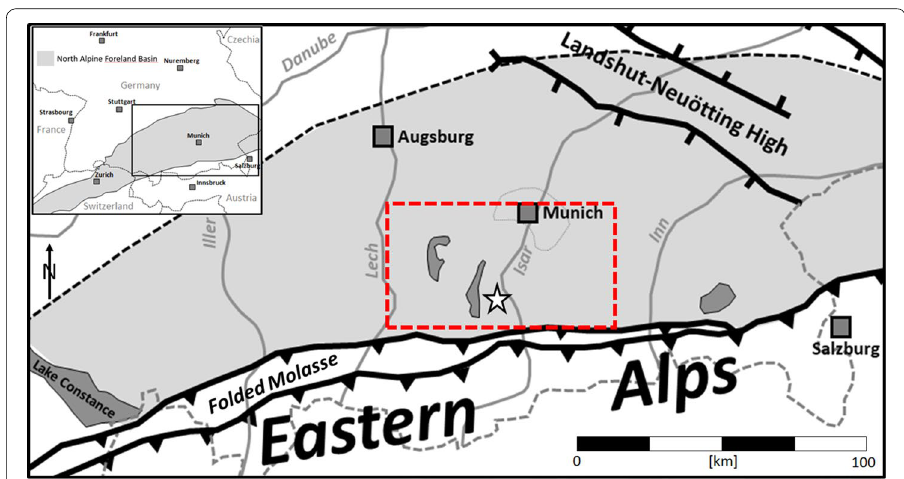
Fig. 1 Map of the North Alpine Foreland Basin in SE Germany [after (Drews et al. 2018; Reinecker et al. 2010)]. The inset illustrates the location of the North Alpine Foreland Basin in SE Germany. The grey area marks the outline of the North Alpine Foreland Basin in Germany and Western Switzerland. The study area is indicated by the red-dashed rectangle. The approximate location of the Geretsried GEN-1 well is highlighted with a white star